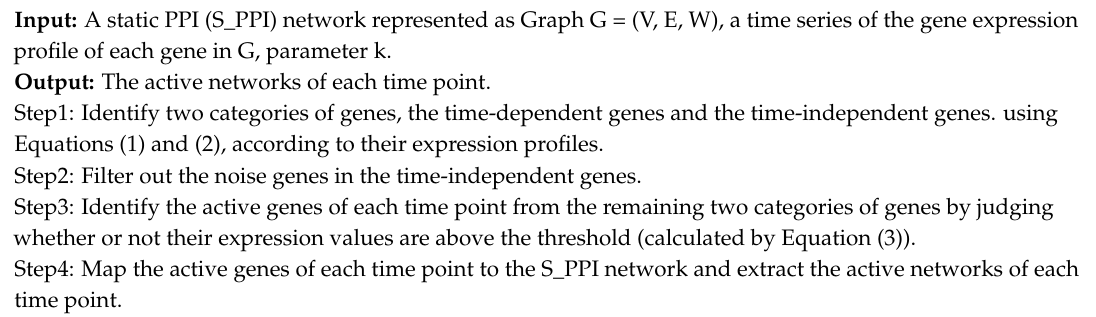
Algorithm 1 Dynamic Network